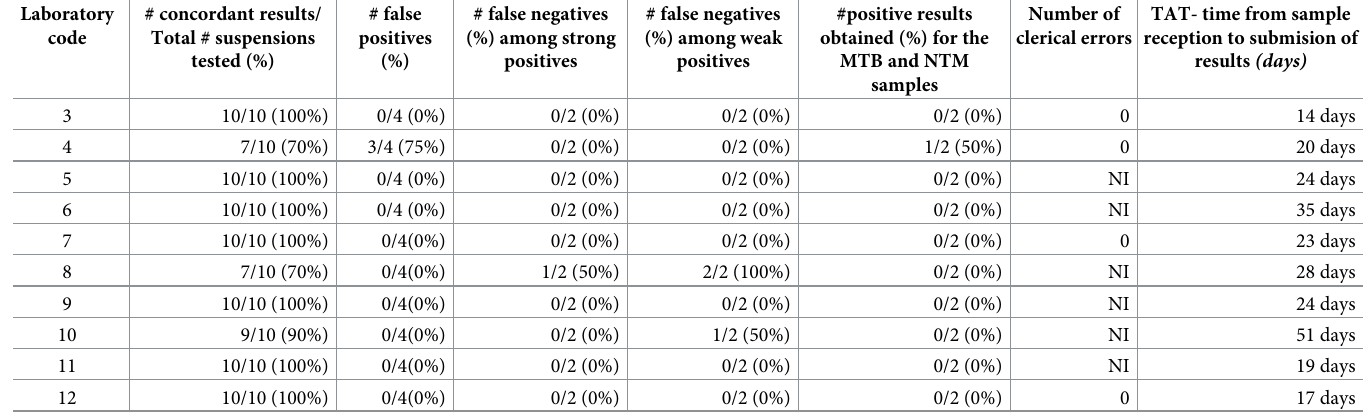
Table 3. Qualitative results in the first round BU-LABNET EQA